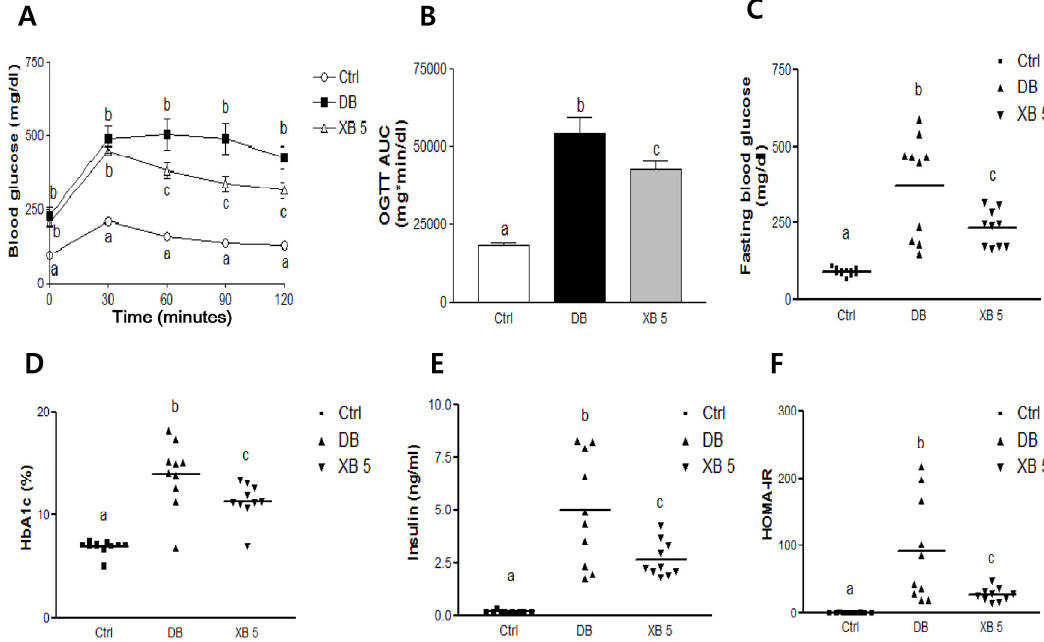
Figure 2. Oral glucose tolerance test (OGTT), fasting blood glucose (FBG), and blood glucose related biochemical profiles. ( A ) OGTT was measured every 30 min following administration of a